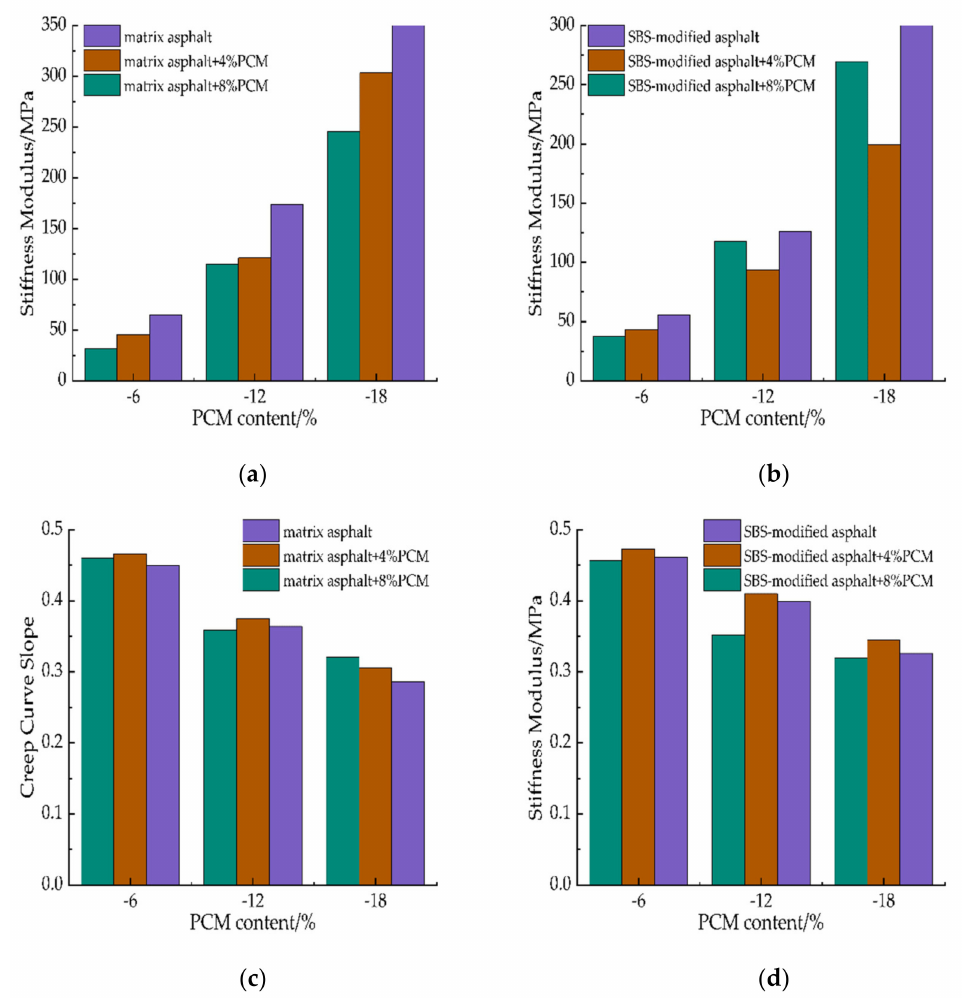
Figure 7. BBR test results of asphalt samples with PCM under different test temperatures. ( a ) stiffness modulus of matrix asphalt samples; ( b ) stiffness modulus of SBS − modified asphalt samples; ( c ) creep curve slope of matrix asphalt samples; ( d ) creep curve slope of SBS − modified asphalt